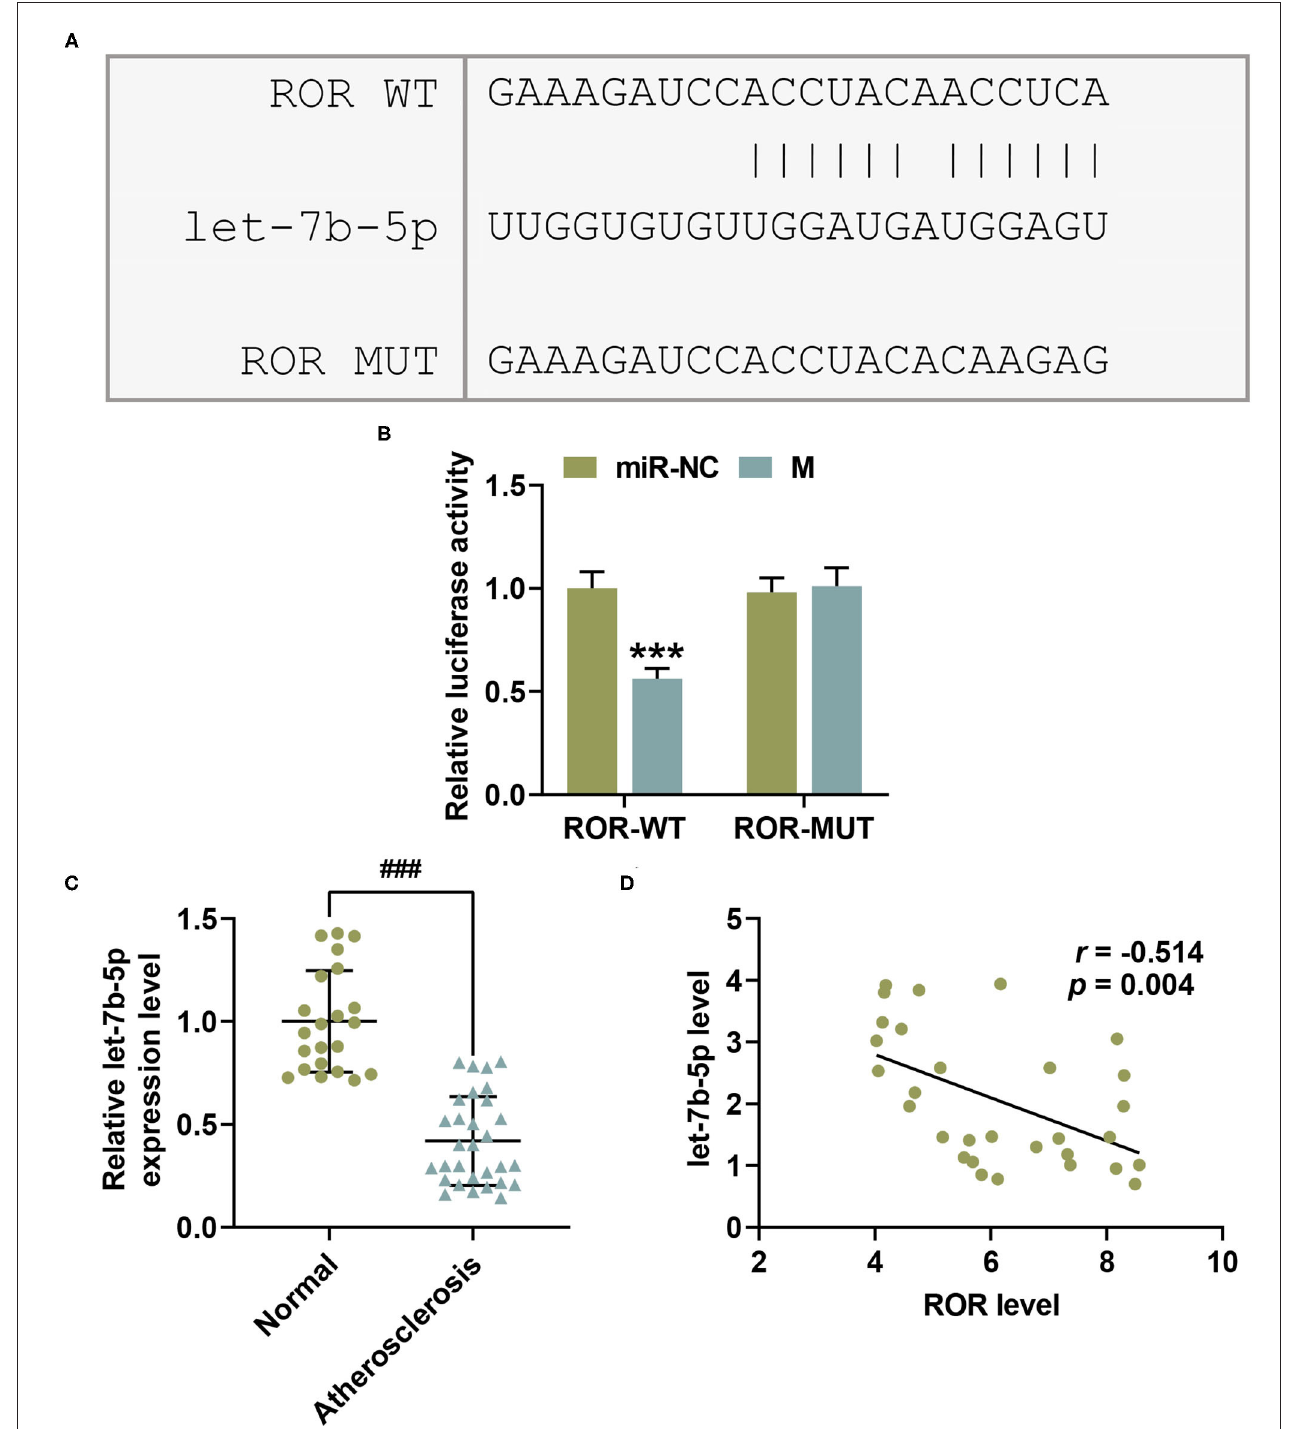
FIGURE 2 | let-7b-5p inversely bound with lncRNA regulator of reprogramming (ROR), with its expression being downregulated in AS. (A) The predicted potential binding sites between lncRNA ROR and let-7b-5p are listed. (B) Dual-luciferase reporter assay confirmed that let-7b-5p could bind with lncRNA ROR. (C) The relative let-7b-5p expressions in peripheral venous blood from patients with atherosclerosis ( n = 30) and healthy donors (normal, n = 22) were measured with qRT-PCR. U6 was used as an internal control. (D) Pearson’s correlation test showed a negative correlation between let-7b-5p and lncRNA ROR. All the experiments have been performed independently in triplicate, and the data were expressed as mean ± standard deviation. Statistical significance was assessed by paired t -test and one-way ANOVA, followed by Tukey’s post-hoc test. A correlation analysis of lncRNA ROR and let-7b-5p was performed using Pearson’s correlation test. *** P < 0.001 vs . miR-NC; ### P < 0.001 vs .